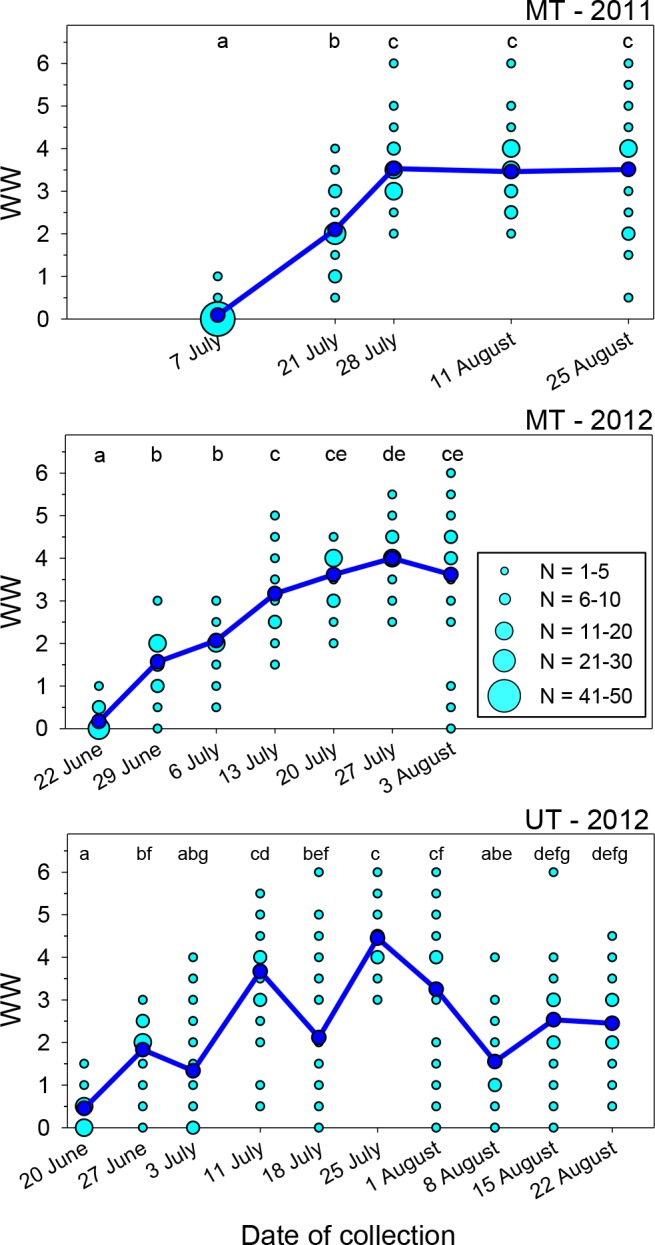
Seasonal changes in the index of wing wear (WW).Light blue circles represent raw data, dark blue circles and solid lines represent the mean values for each date. Means associated with different letters are significantly different at P < 0.05 (Dunn’s Test). Total sample sizes for each date were N = 50 (MT 2011) and N = 30 (MT 2012 and UT 2012).